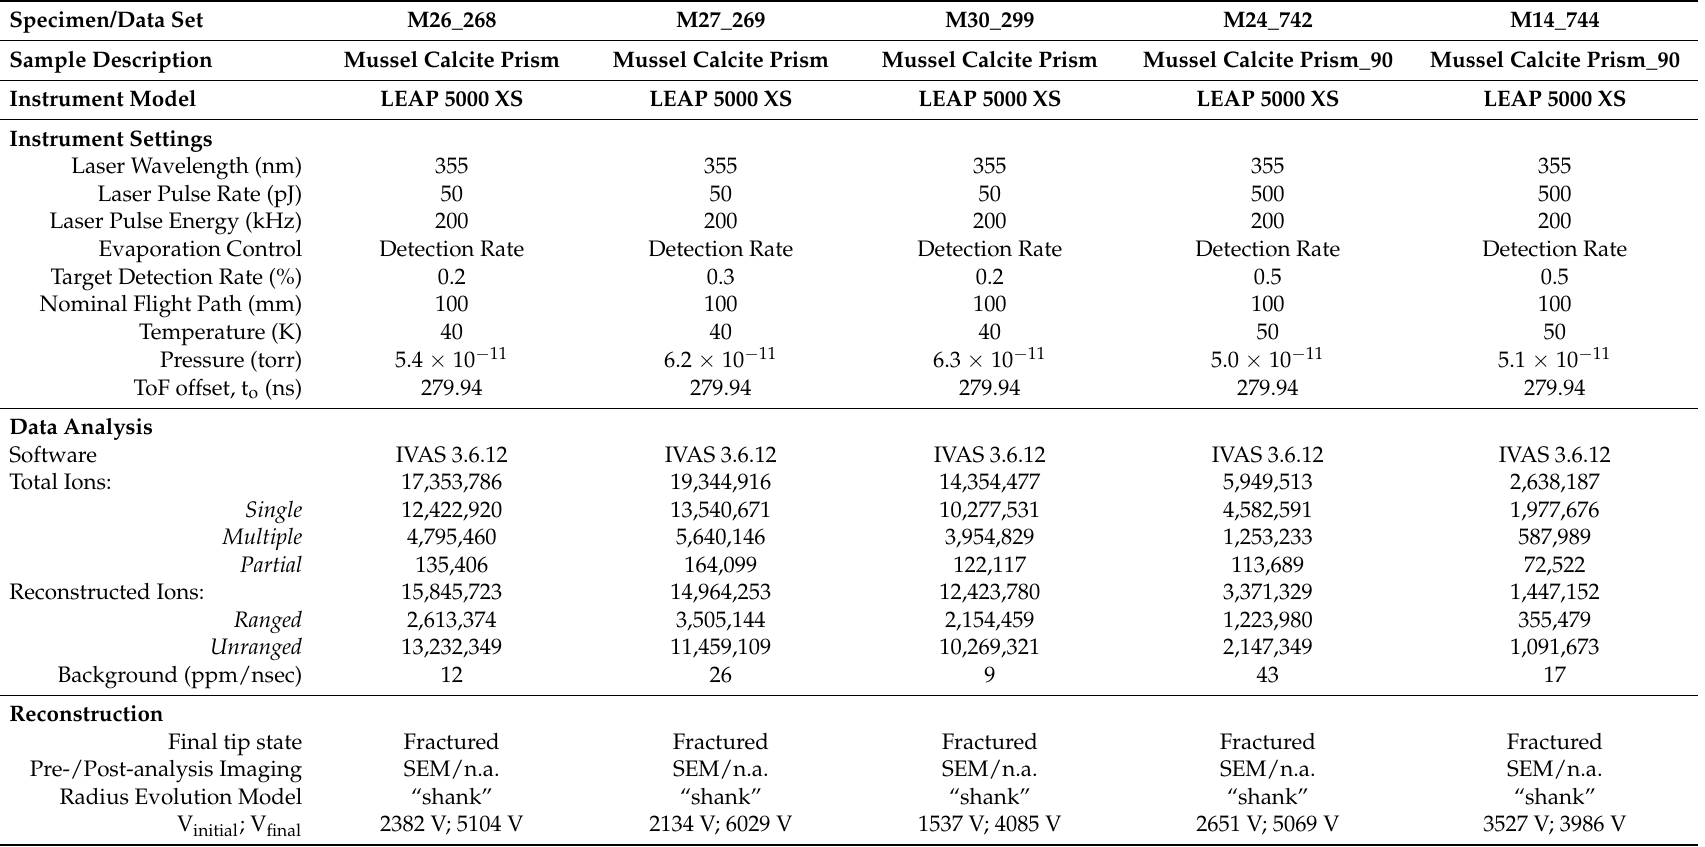
Table 1. Atom probe tomography data acquisition settings and run